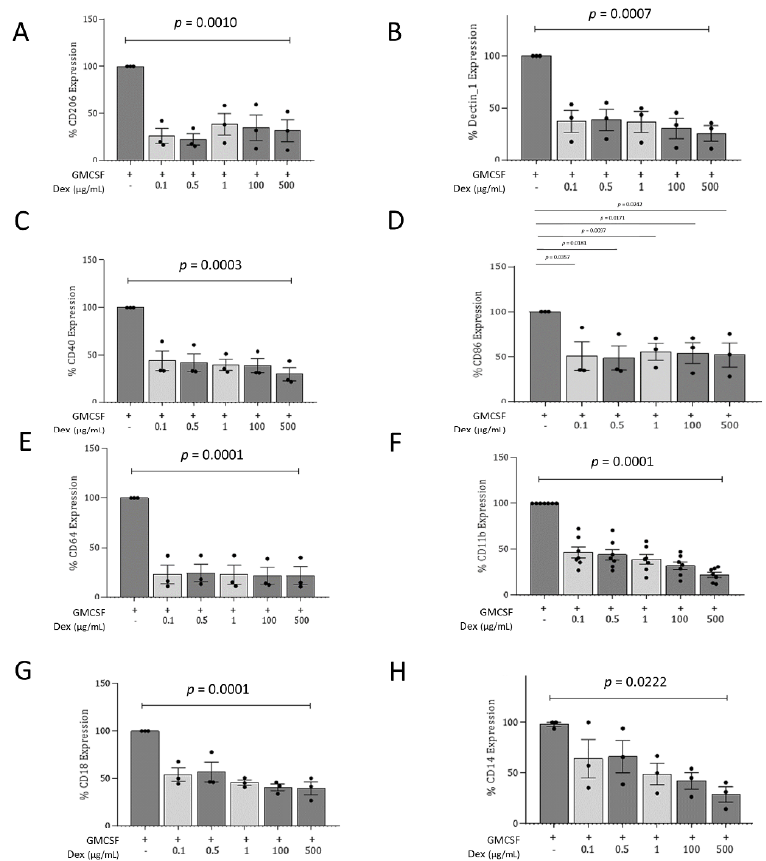
Figure 2 . Dexamethasone impairs expression of pattern recognition receptors (PRRs) and co-stimulatory molecules, Fc γ RI, CR3, and CD14 on macrophages. Again, macrophages (1 × 10 6 /mL) were cultured for 7 days in the presence of GM-CSF alone or in combination with Dex (0.1 to 500 µg/mL). Flow cytometric analysis revealed that treatment significantly reduced the expression of ( A ) CD206, ( B ) Dectin-1, ( C ) CD40, ( D ) CD86, ( E ) CD64, ( F ) CD11b, ( G ) CD18, and ( H ) CD14. Graphs represent percentage expression of characteristic receptors expressed on macrophages. All experiments were independently repeated at least 3 times. Graphs representing mean fluorescence intensity (MFI) ± SD as well as a representative histogram plot of GM-MDMs, Dex-MDMs, or EtOH controls are illustrated in Suppl. Figure S3. p -values were calculated by one-way